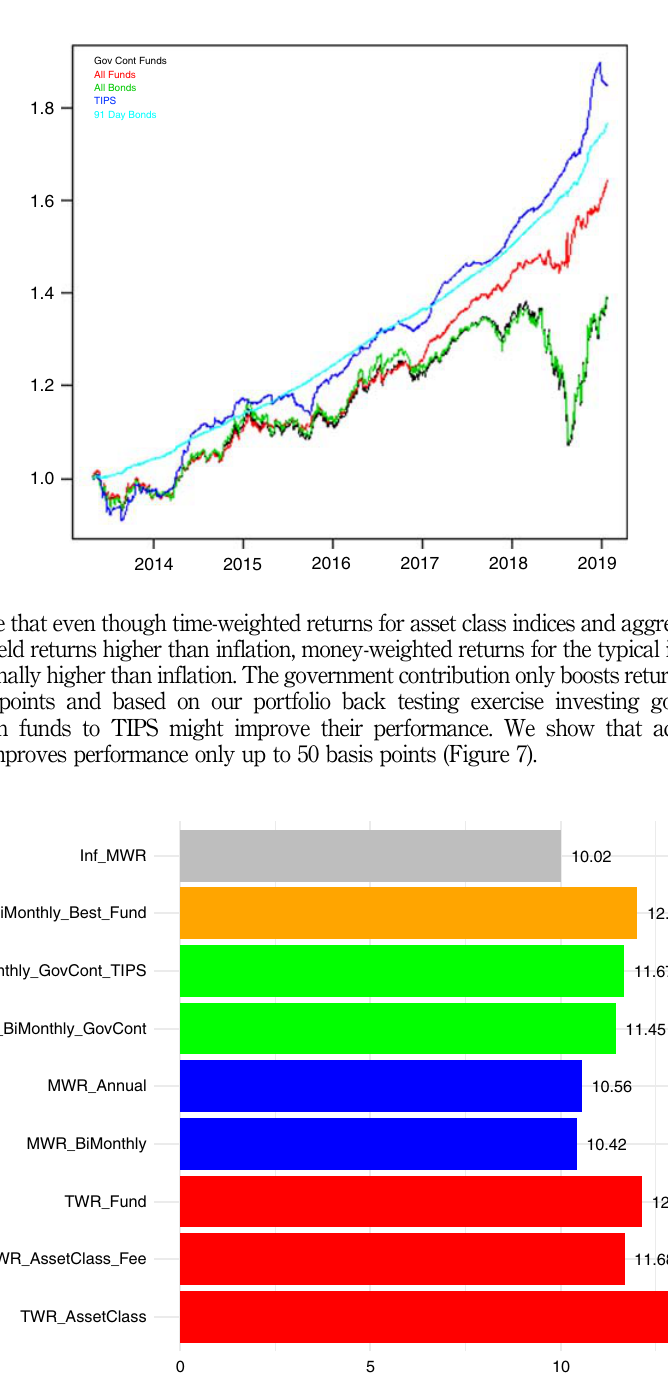
Figure 7. Sources of money-weighted investor